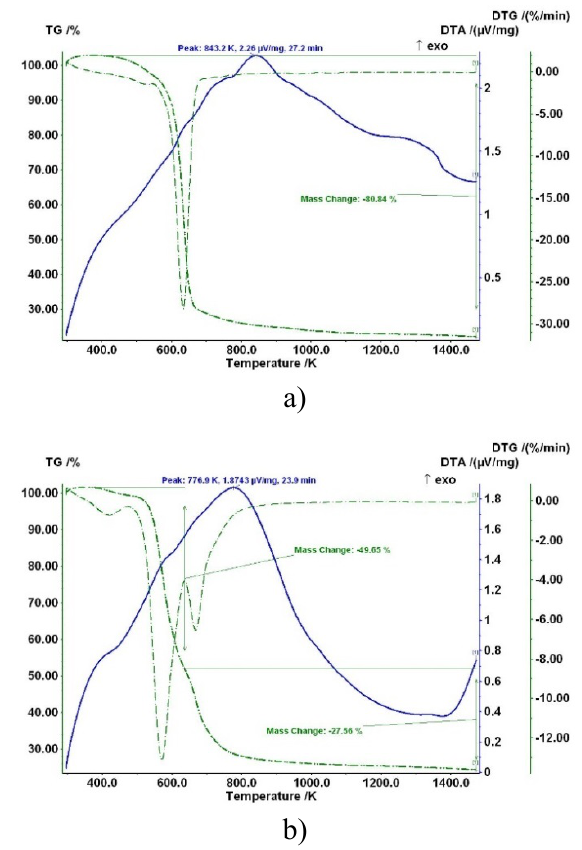
Figure 3. DTA/TG/DTG of cigarette butts (a) and waste coffee grounds